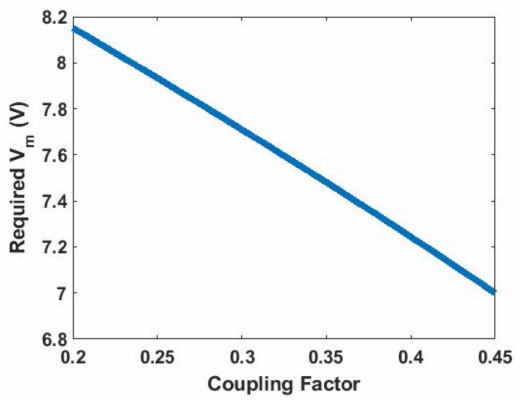
Figure 13. V m to achieve 100 mA charging current under different coupling